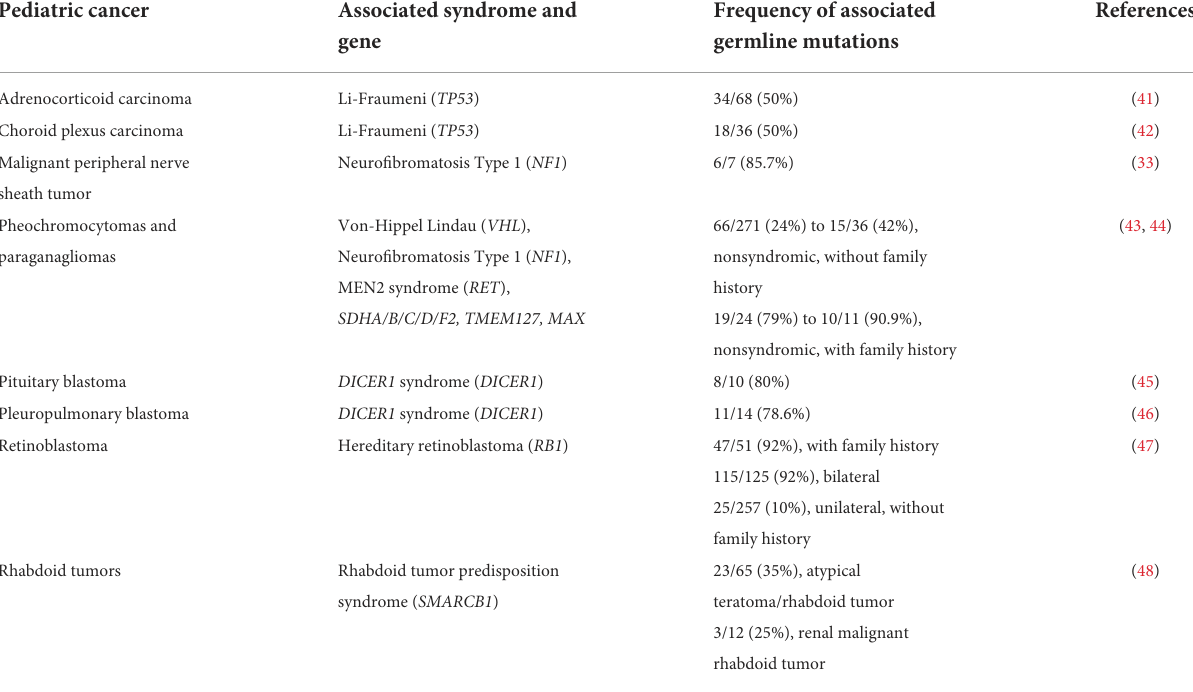
TABLE 3 Pediatric cancers with a high frequency of associated germline